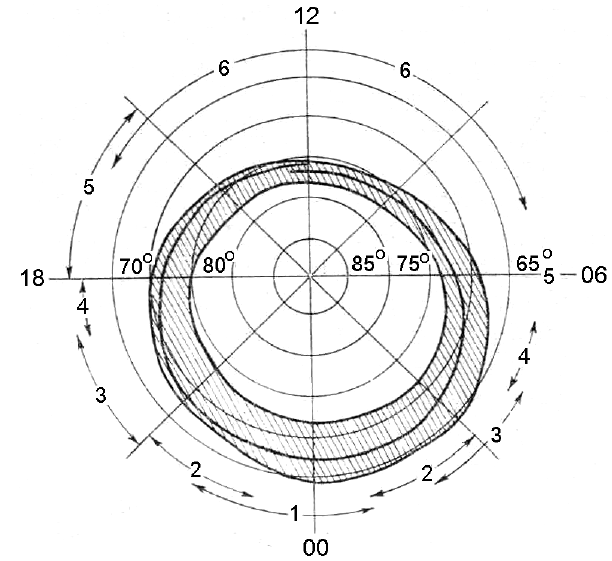
Figure 9. Auroral belt (bold line) obtained from auroral orientation observations at the stations Dixon Island (1), Point Barrow (2), Fort Churchill (3), Cape Chelyuskin (4), Wiese Island (5), and Pyramida, Spitzbergen (6). The hatched area shows the position of the auroral oval. The digits 1–6 denote the MLT intervals, during which the observed azimuths at the corresponding stations were obtained for the construction of the current auroral belt (Starkov and Feldstein,